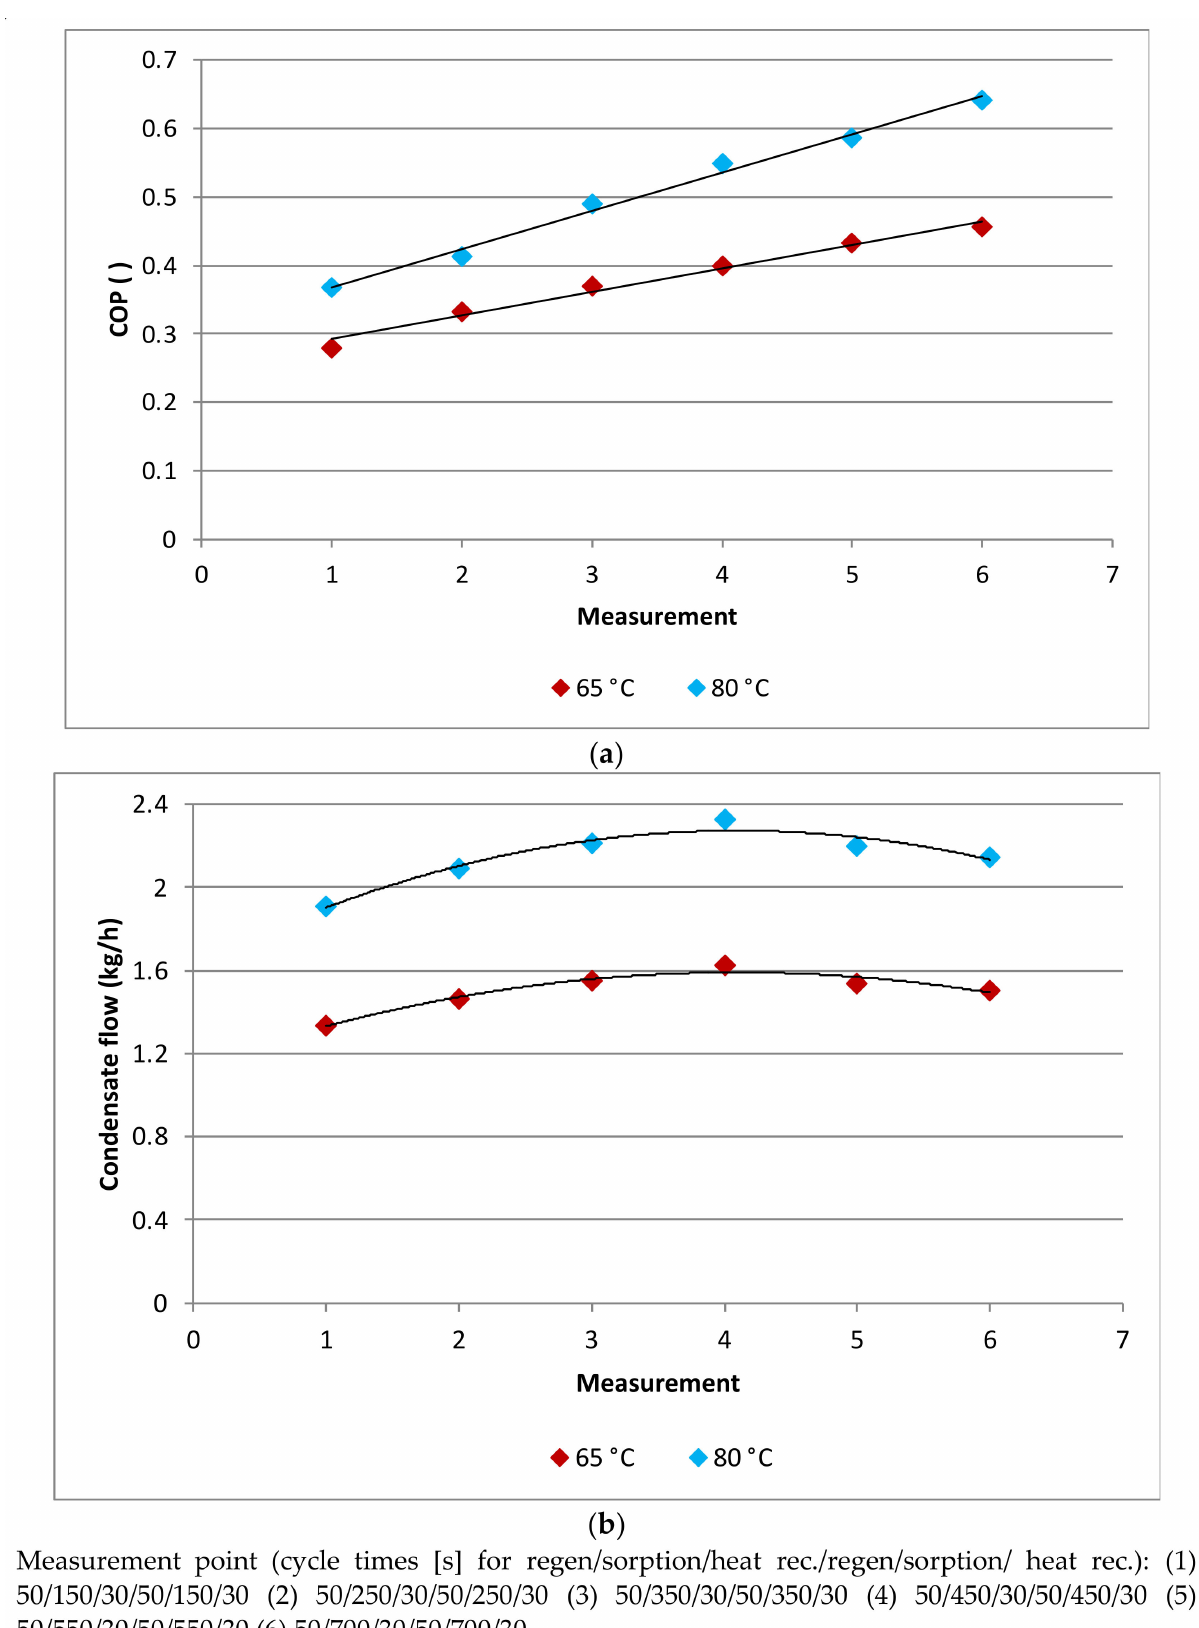
Figure 11. Experimental testing results in GROUP 3 at the hot water temperatures of 80 ◦ C and 65 ◦ C: ( a ) COP; ( b ) conden- sate